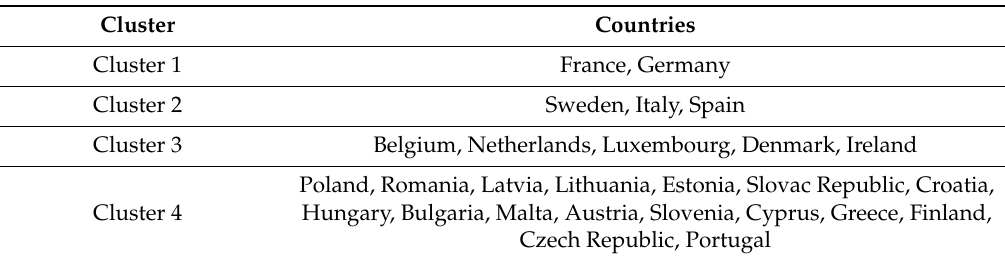
Figure 10. Dendrogram derived from the average linkage method (Output: R package). Table 6. Cluster analysis